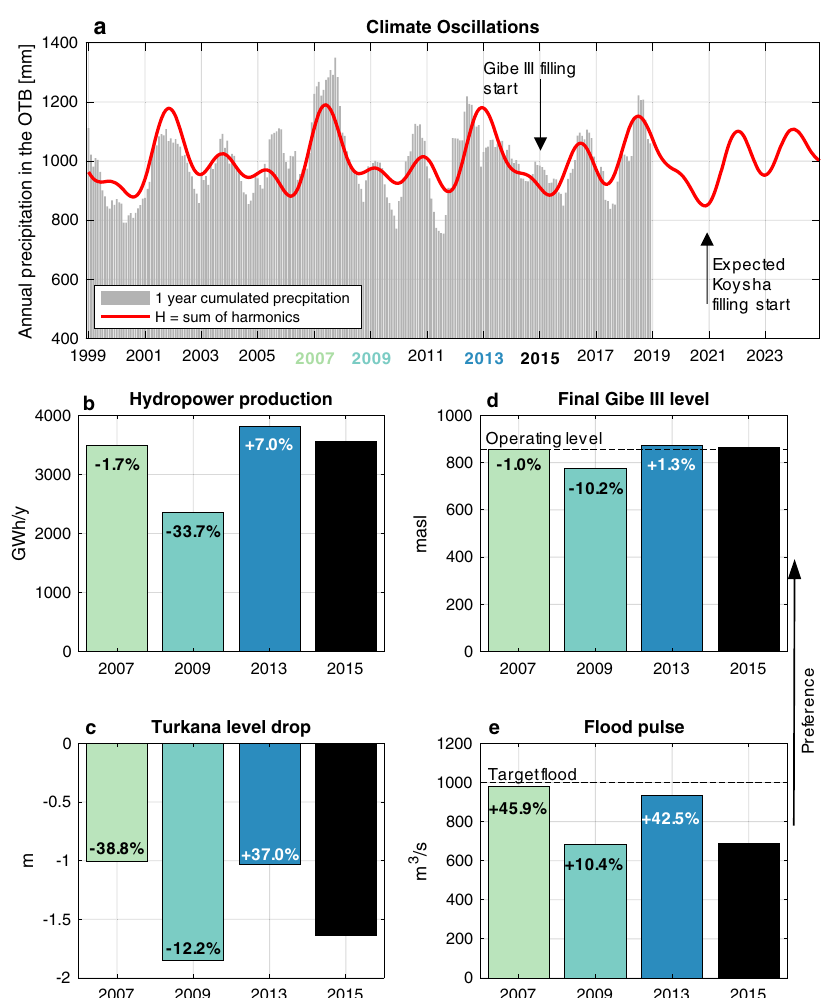
Fig. 3 Climatic oscillations can inform a favorable timing for fi lling. A pattern of harmonic climatic oscillations governs the magnitude of annually cumulated rainfall occurring on the OTB, shown at a monthly time step ( a ). Panels ( b – e ) contrast the historical 2015 fi lling performance (black bar) with alternative fi lling timings (colored bars) with respect to relevant indicators. The bar labels report the percentage change in the value of the indicator with respect to the historical performance. Filling Gibe III reservoir during an upwards phase of water availability (e.g., 2013), instead of a downwards phase as historically, could have resulted in a more ef fi cient, and less con fl ictual fi lling. By projecting the harmonic trends into the future, we advise to delay Koysha fi lling by one year and begin in 2022 instead of the planned 2021, as the additional stress caused by a bad timed fi lling stress could have detrimental consequences on the fragile social and ecological balances of the